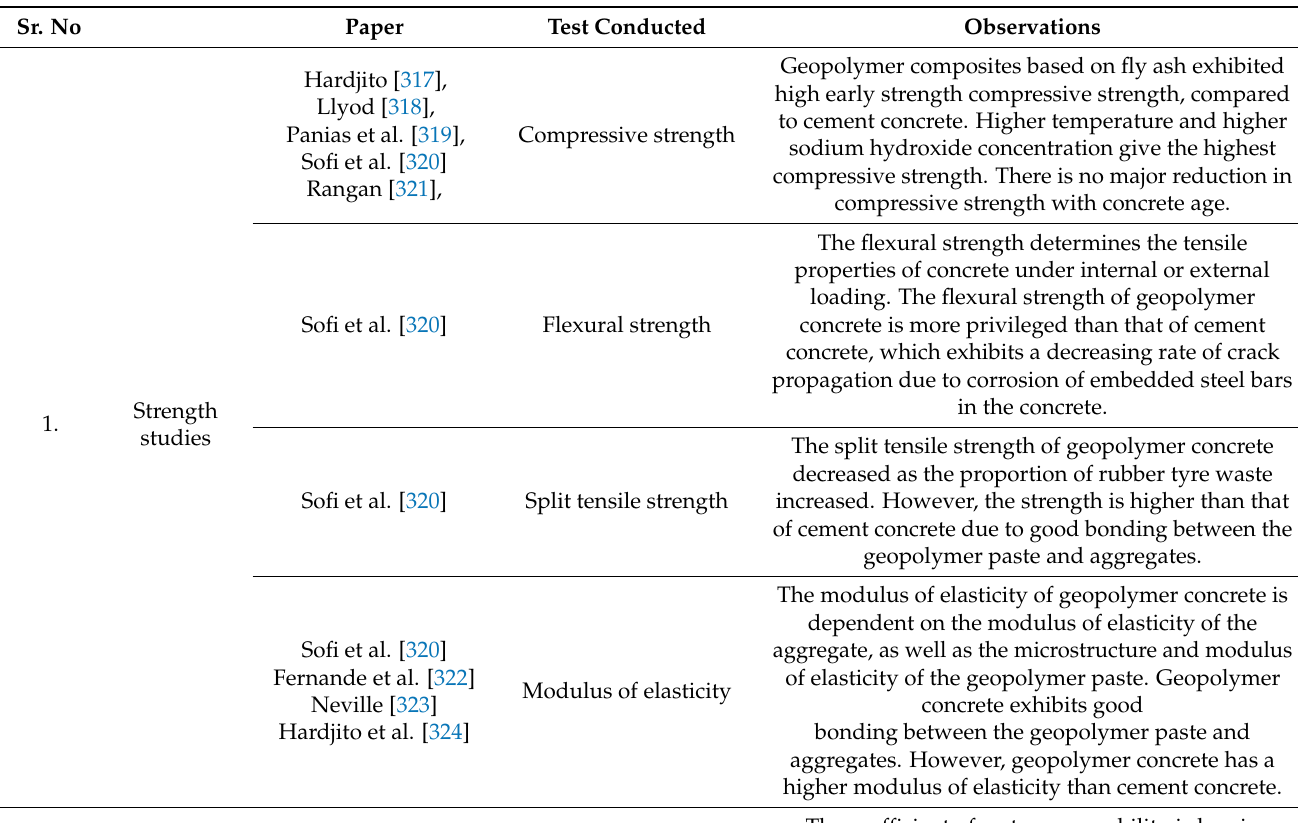
Table 2. Existing literature properties of geopolymer